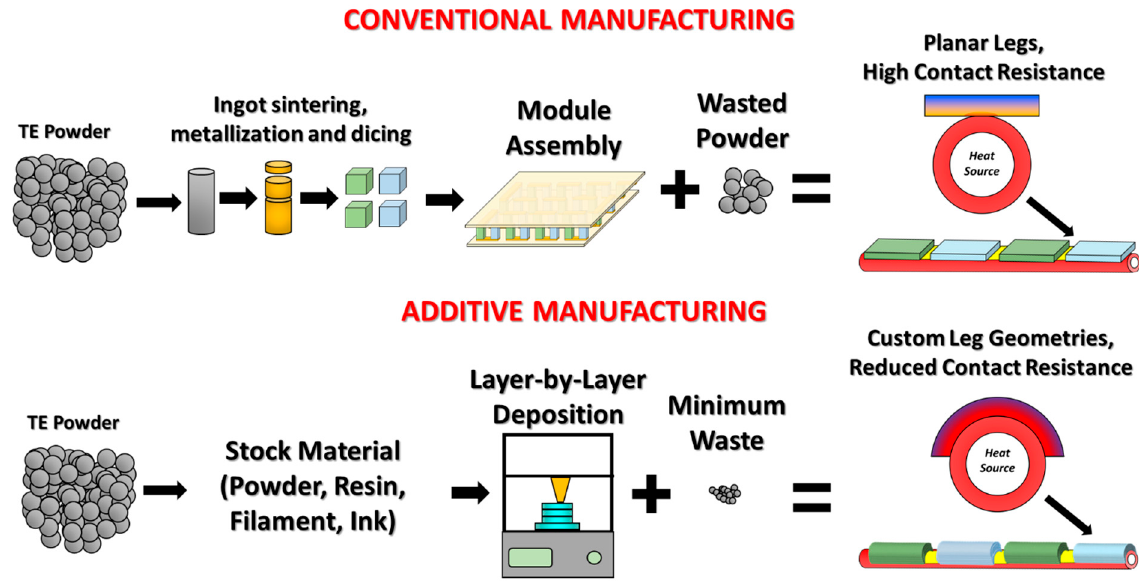
Figure 1 . Comparison of additive and conventional manufacturing for TE materials Figure 1. Comparison of additive and conventional manufacturing for TE materials.